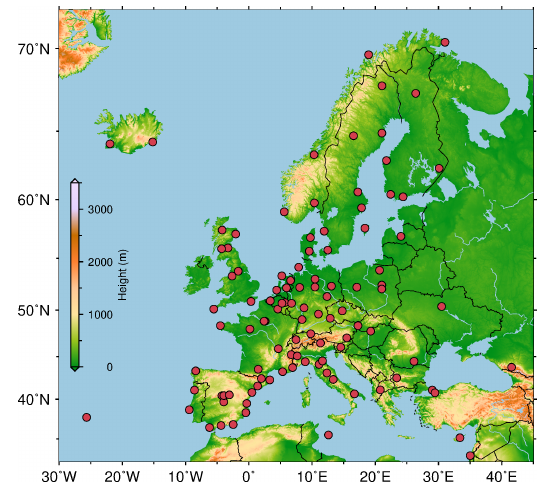
Figure 1. Geographical distribution of the 108 GPS stations (red dots). An enlarged version of this figure with station names is pro- vided in Fig. S1. The coordinates of the stations and their time lengths are provided in Table